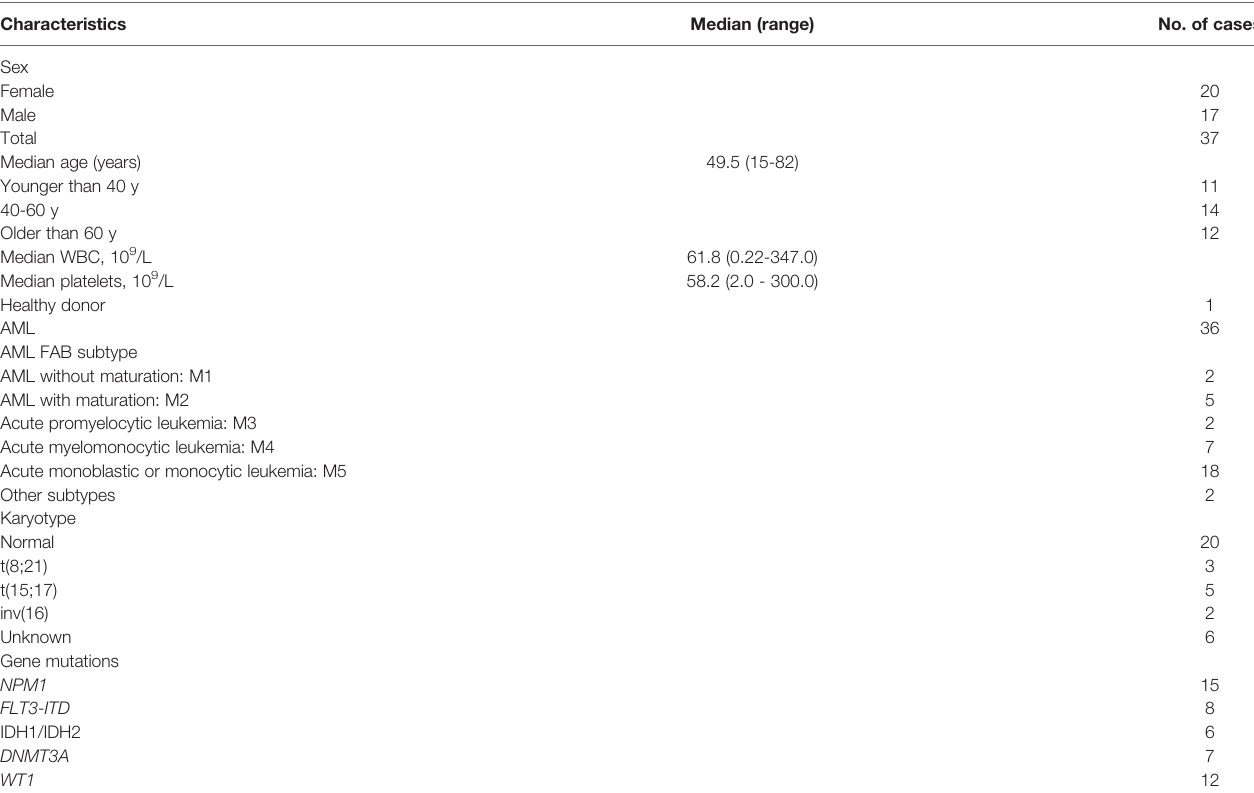
TABLE 1 | Clinical characteristics of newly diagnosed AML patients.